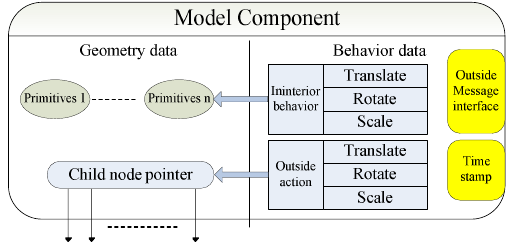
Figure 4. Sketch map of model component